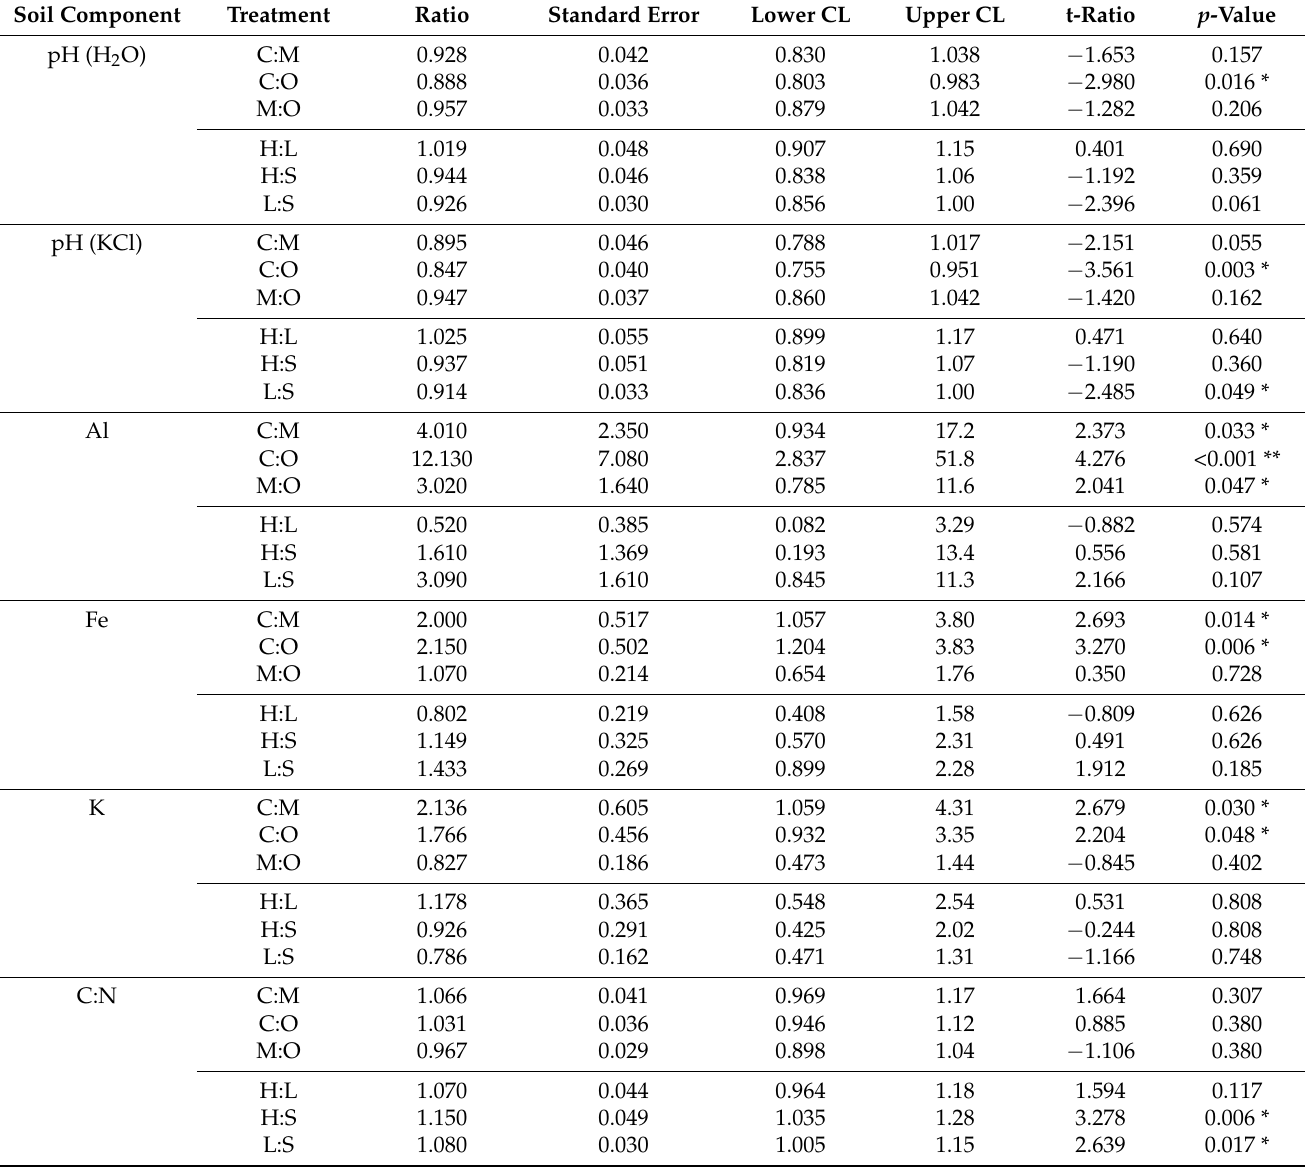
pairwise ratios from estimated marginal means taken from generalised linear